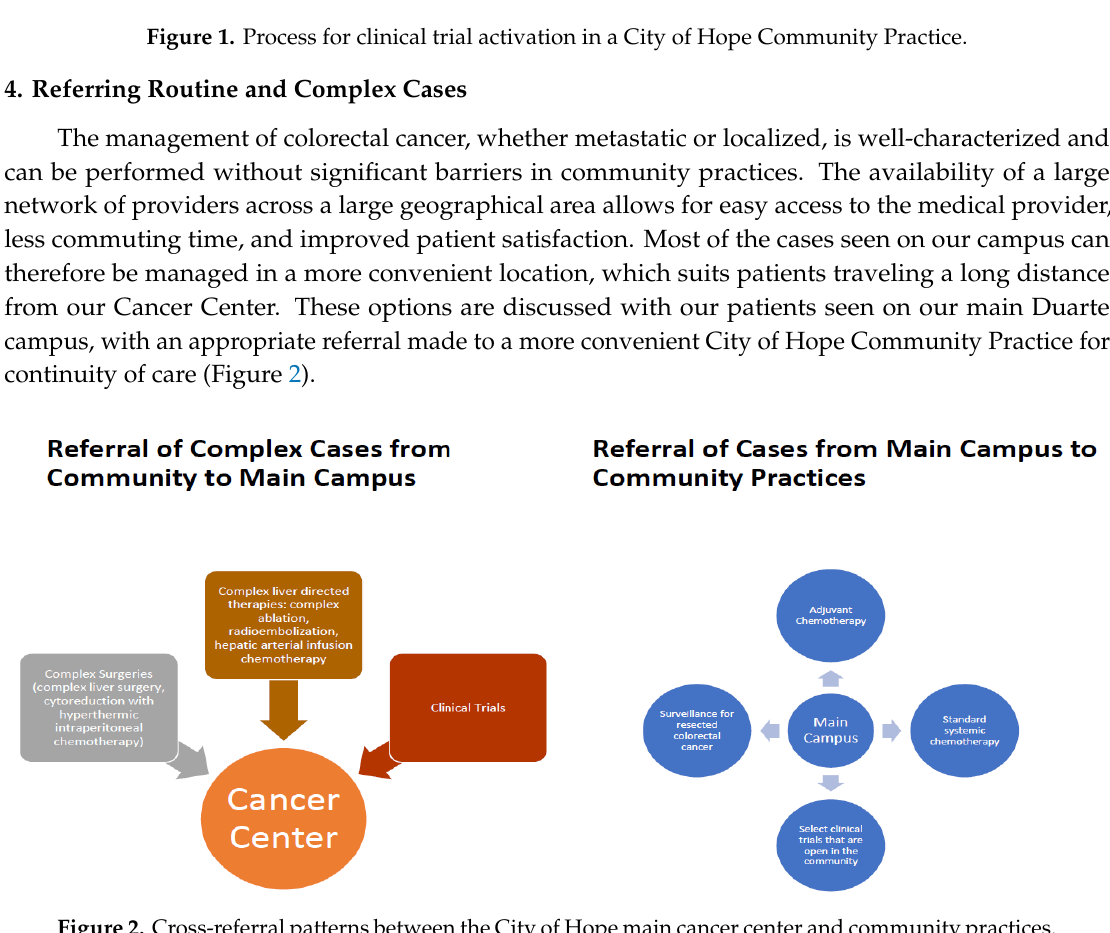
Figure 2. Cross-referral patterns between the City of Hope main cancer center and community practices.